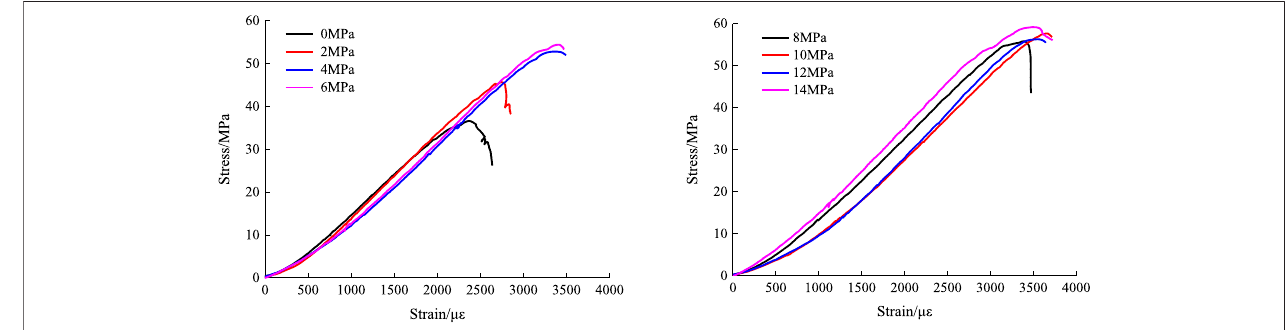
FIGURE 7 | The principal compressive stress-strain curve of SCC under biaxial compression-compression.